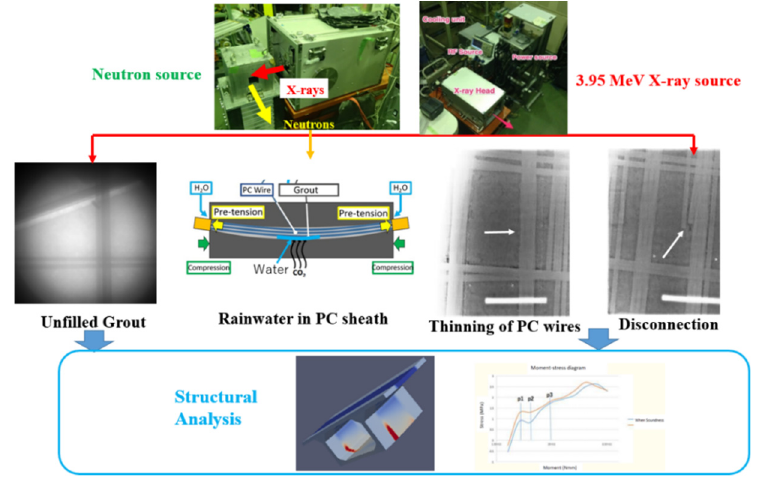
Figure 11. Procedure of X-ray inspection, flaw evaluation, and structural analysis.